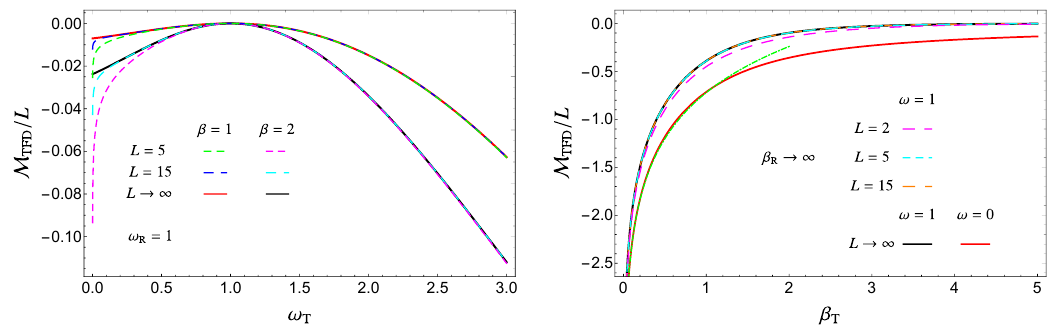
Figure 8 . Comparison between the mutual complexity for the TFD state (9.59) and its thermody- namic limit in the periodic harmonic chain (here κ = m = 1 ). In the left panel we show M /L TFD as function of ω setting ω = 1 and considering two values of β = β ≡ β and two values of L T R R T (dashed curves). We also report a in (9.67) for the same values of the parameters (solid curves). TFD In the right panel the dependence on β is investigated by plotting (9.59) for three different values T of L (dashed curves) and (9.67) (black solid curve) both for β → ∞ and ω = ω ≡ ω = 1 . The R R T massless limit in (9.69) is also reported (red solid curve) and its small β behaviour in (9.70) is T checked (green dot-dashed